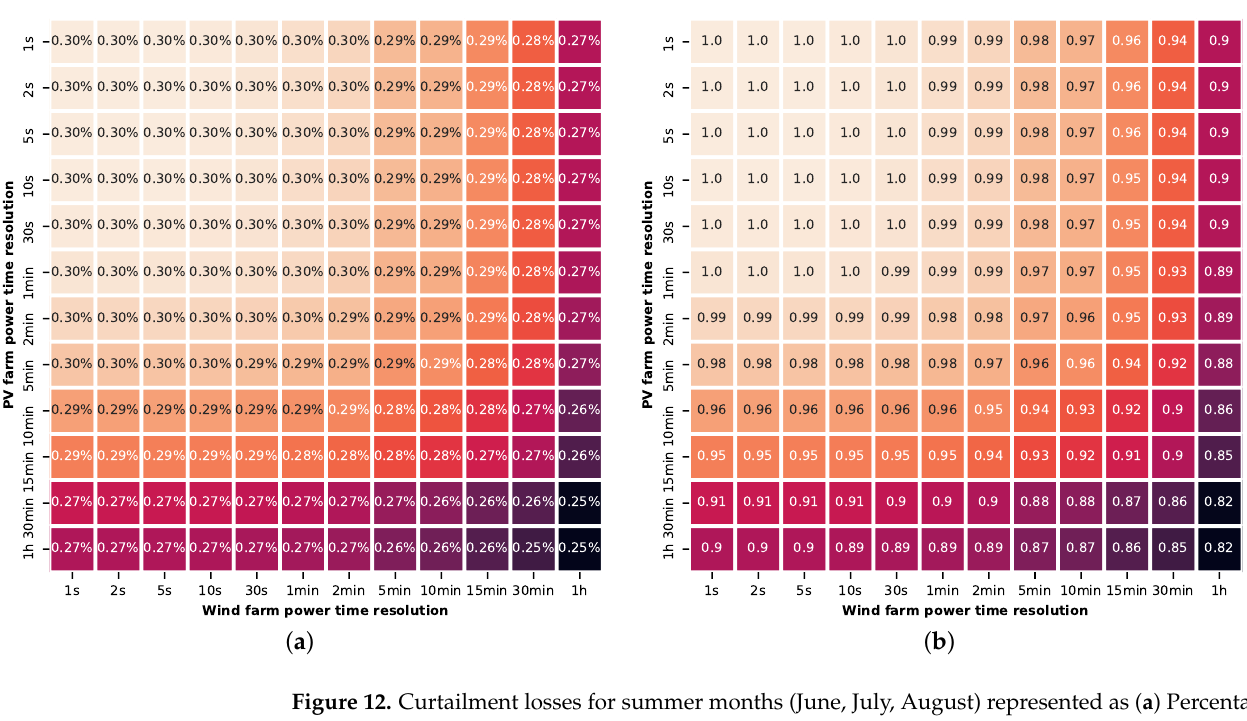
Figure 11. Curtailment losses for spring months (March, April, May) represented as ( a ) Percentage curtailment losses and ( b ) Relative curtailment losses to 1 s wind and solar PV time resolution.